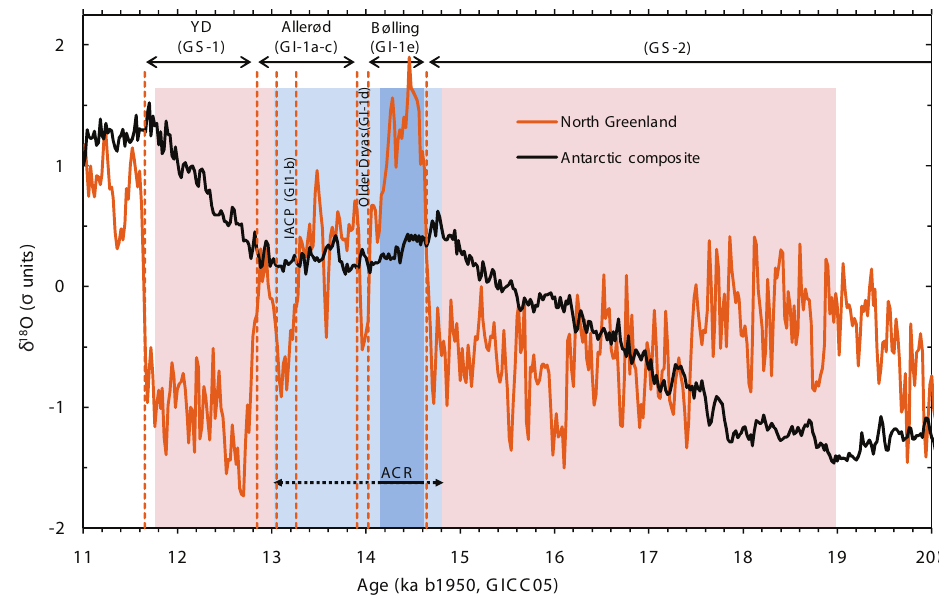
Fig. 5. A comparison of the pattern and timing of climate change in the Antarctic and North Atlantic regions during the last deglaciation: the Antarctic composite δ 18 O ice record and the North Greenland (NGRIP) δ 18 O ice record. Vertical pink bands correspond to periods of significant Antarctic warming, vertical light blue bands correspond to a pause in Antarctic warming, and the vertical dark blue band corresponds to significant Antarctic cooling. The minimum duration of the ACR is the period spanned by the dark blue band, the maximum duration of the ACR also includes the periods spanned by the light blue bands (as marked by the solid and dashed horizontal lines below the ACR label). Dashed vertical orange lines and labels at the top of the figure show the exact timing of the North Atlantic INTIMATE climate stages (Lowe et al.,